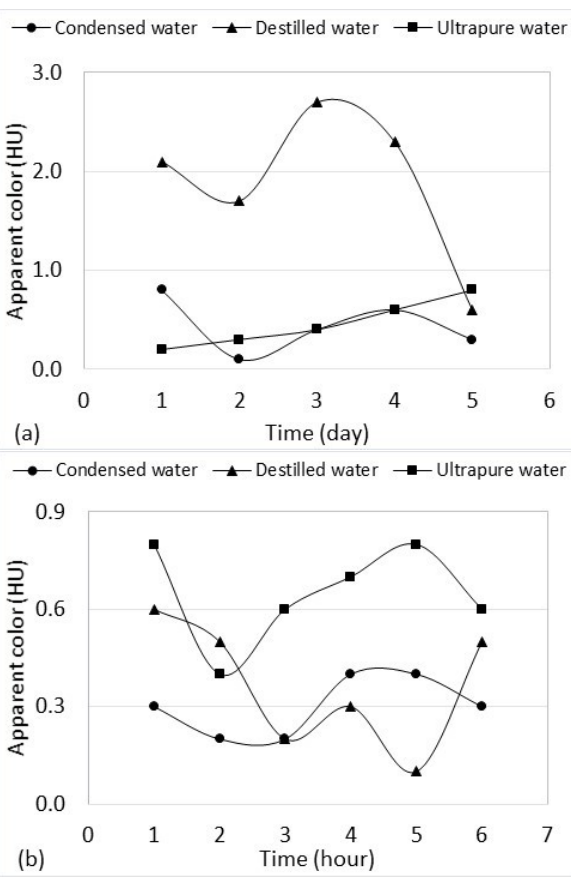
Figure 9: Apparent color values found in condensed, distilled and ultrapure water, with daily (a) and hourly (b) monitoring.